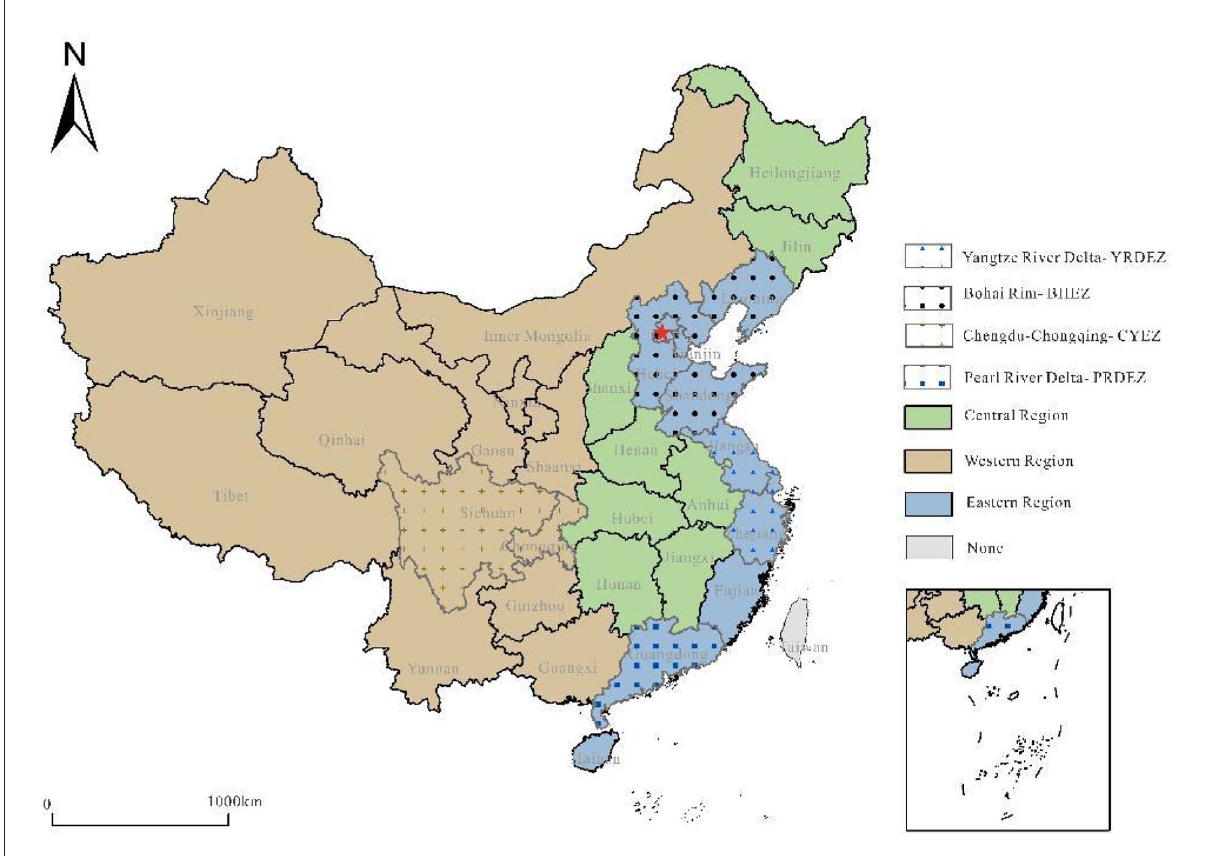
FIGURE2 Research area.